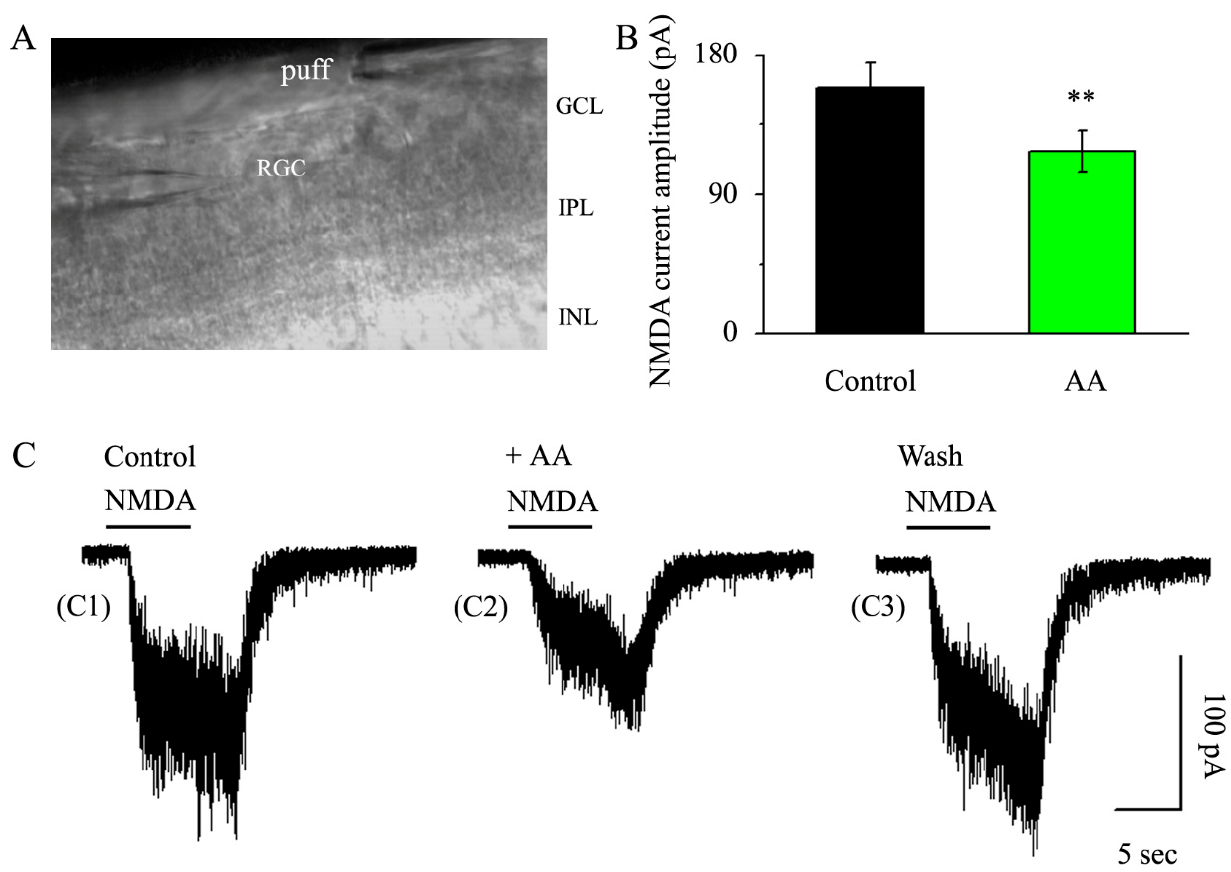
Figure 3. AA reduced the NMDA-induced current amplitude in glaucomatous RGCs. ( A ) Infrared interferometric phase contrast microscopy showed three layers of the inner retina, the inner nuclear layer, the inner plexiform layer and the ganglion cell layer. The recording electrode of the encapsulated cell on the left side and the puff delivery electrode on the right side. ( B ) NMDA-induced postsynaptic receptor current amplitude in control conditions and after AA administration. ( C ) Representative large-scale traces demonstrating the effect of 10 µ M AA on NMDA-induced postsynaptic receptor current under control conditions (C1), AA treatment (C2) and recovery conditions (C3). Scale bars: vertical, 100 pA; horizontal, 5 s. Student’s paired t test; ** p < 0.01 in comparison to the control conditions. GCL, ganglion cell layer; IPL, inner plexiform layer; INL, inner nuclear layer.